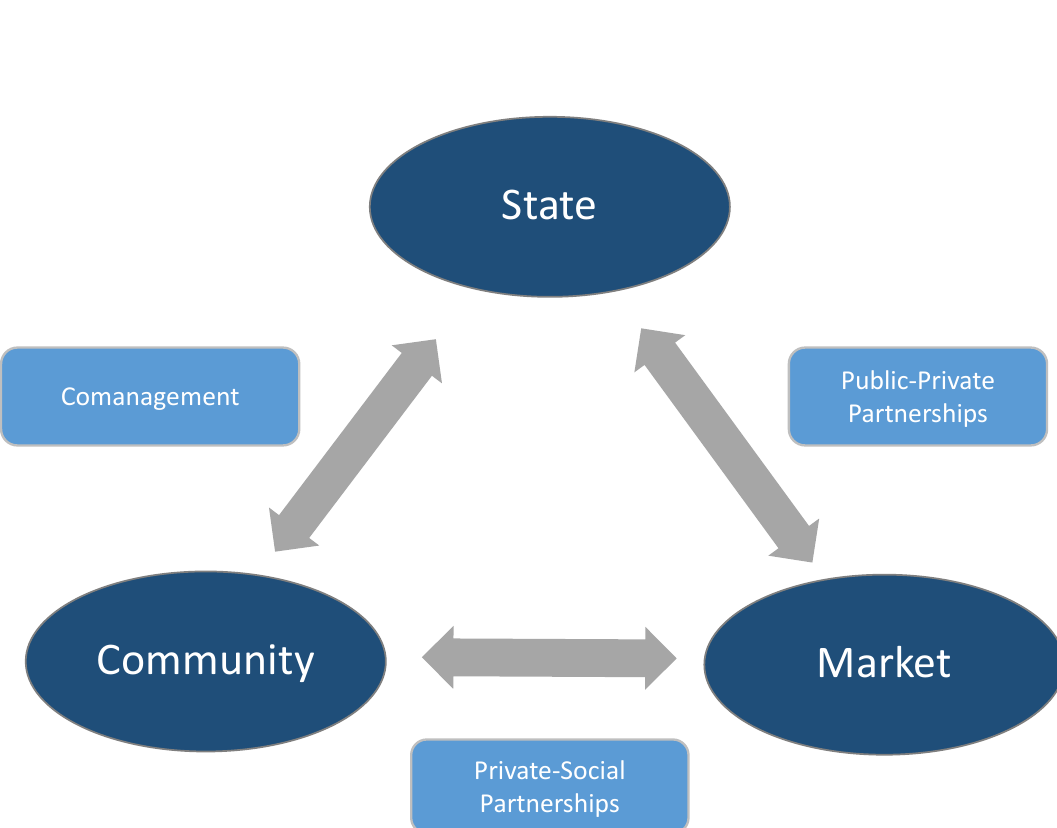
Figure 1. The governance triangle, adapted from Lemos and Agrawal (2006) [18] and (Arts, 2014)